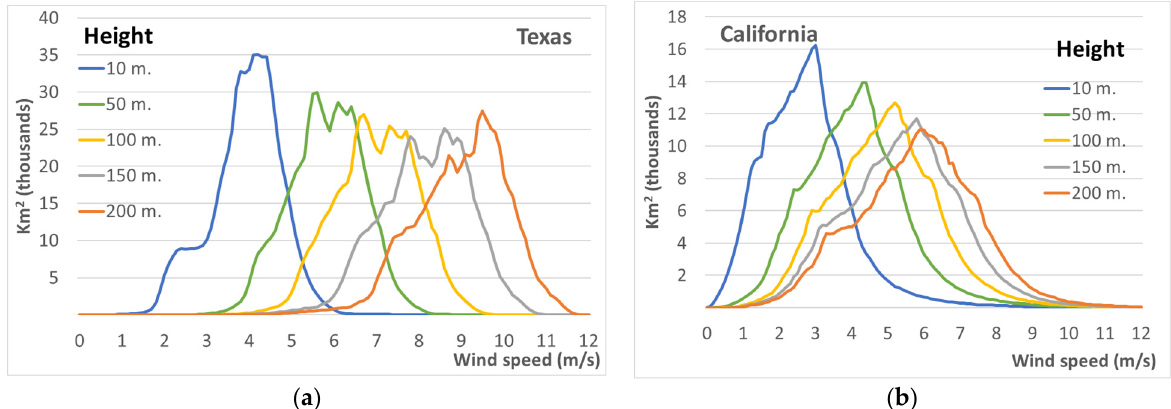
Figure 9. Wind speed distribution per area and height according to the Global Wind Atlas 3.0 for ( a ) Texas and ( b ) Cali- fornia.